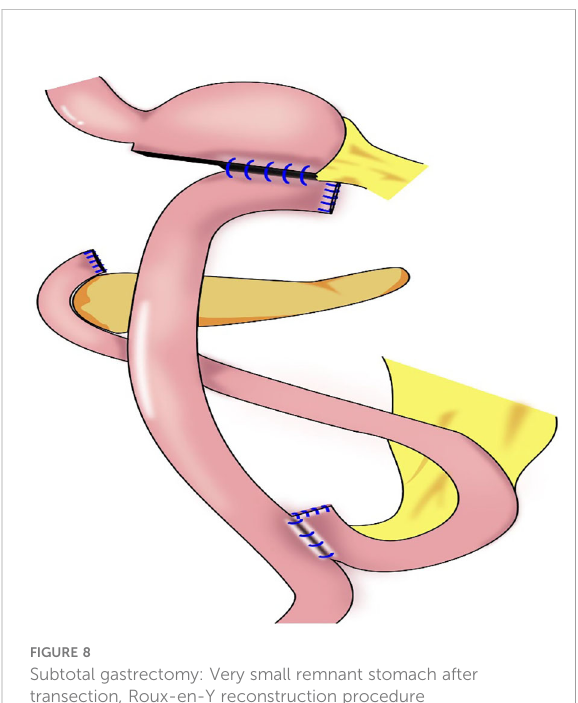
FIGURE 8 Subtotal gastrectomy: Very small remnant stomach after transection, Roux-en-Y reconstruction procedure were performed.